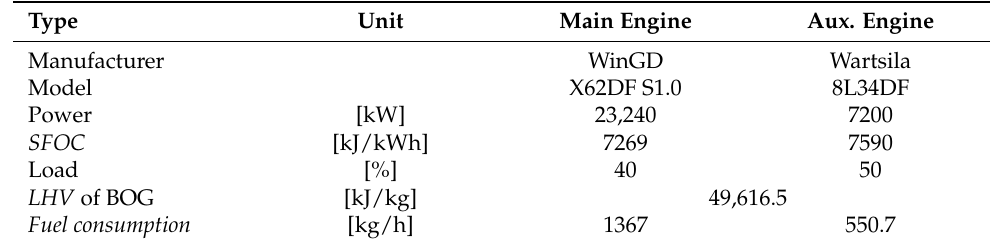
Table 2. Engine specification [29,30].